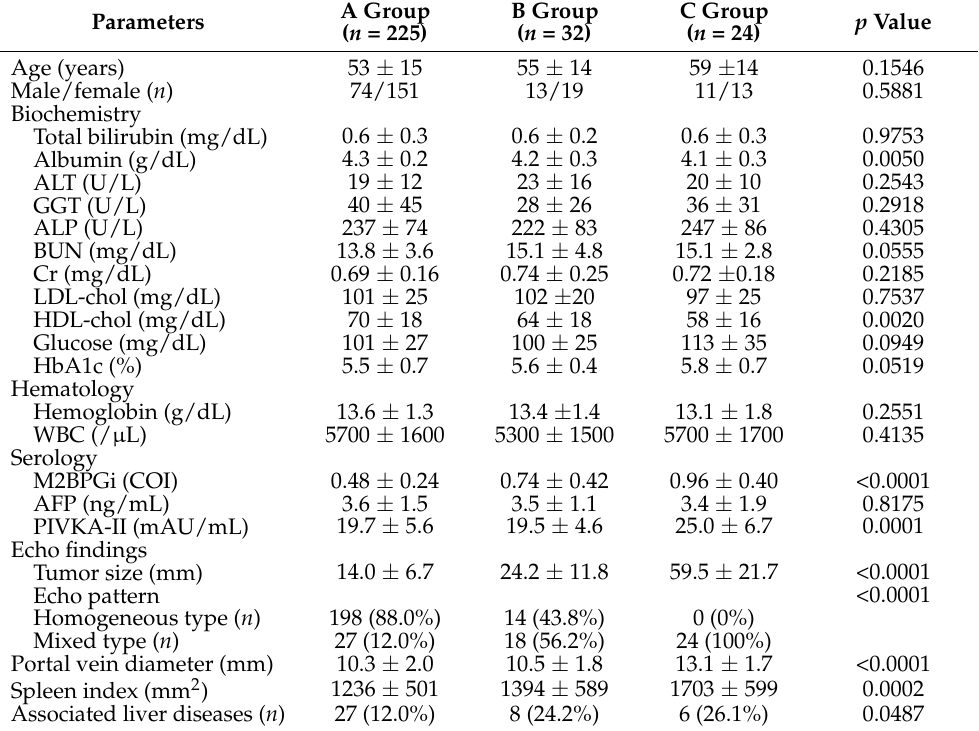
Table 4. Comparison of clinical parameters among groups classified by number of abnormal coagula- tion